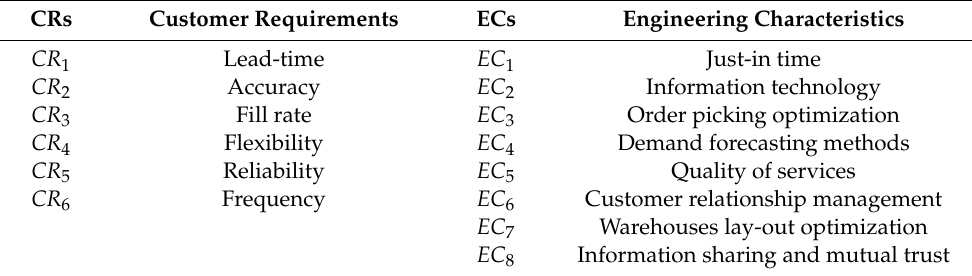
Table 2. CRs and ECs in the case